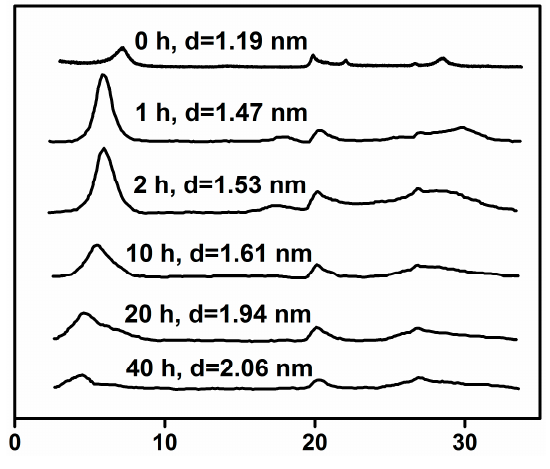
Figure 3. X-ray diffraction (XRD) curves of D-clay obtained at different polymerization times.